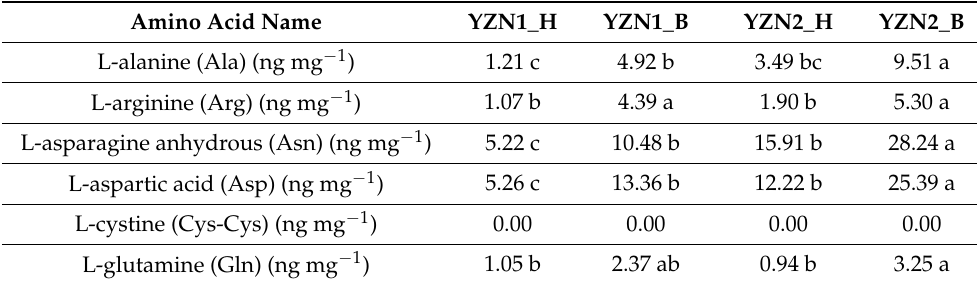
Table 1. Difference analysis of the amino acid content in brown rice grains of two purple rice varieties after processing to polished